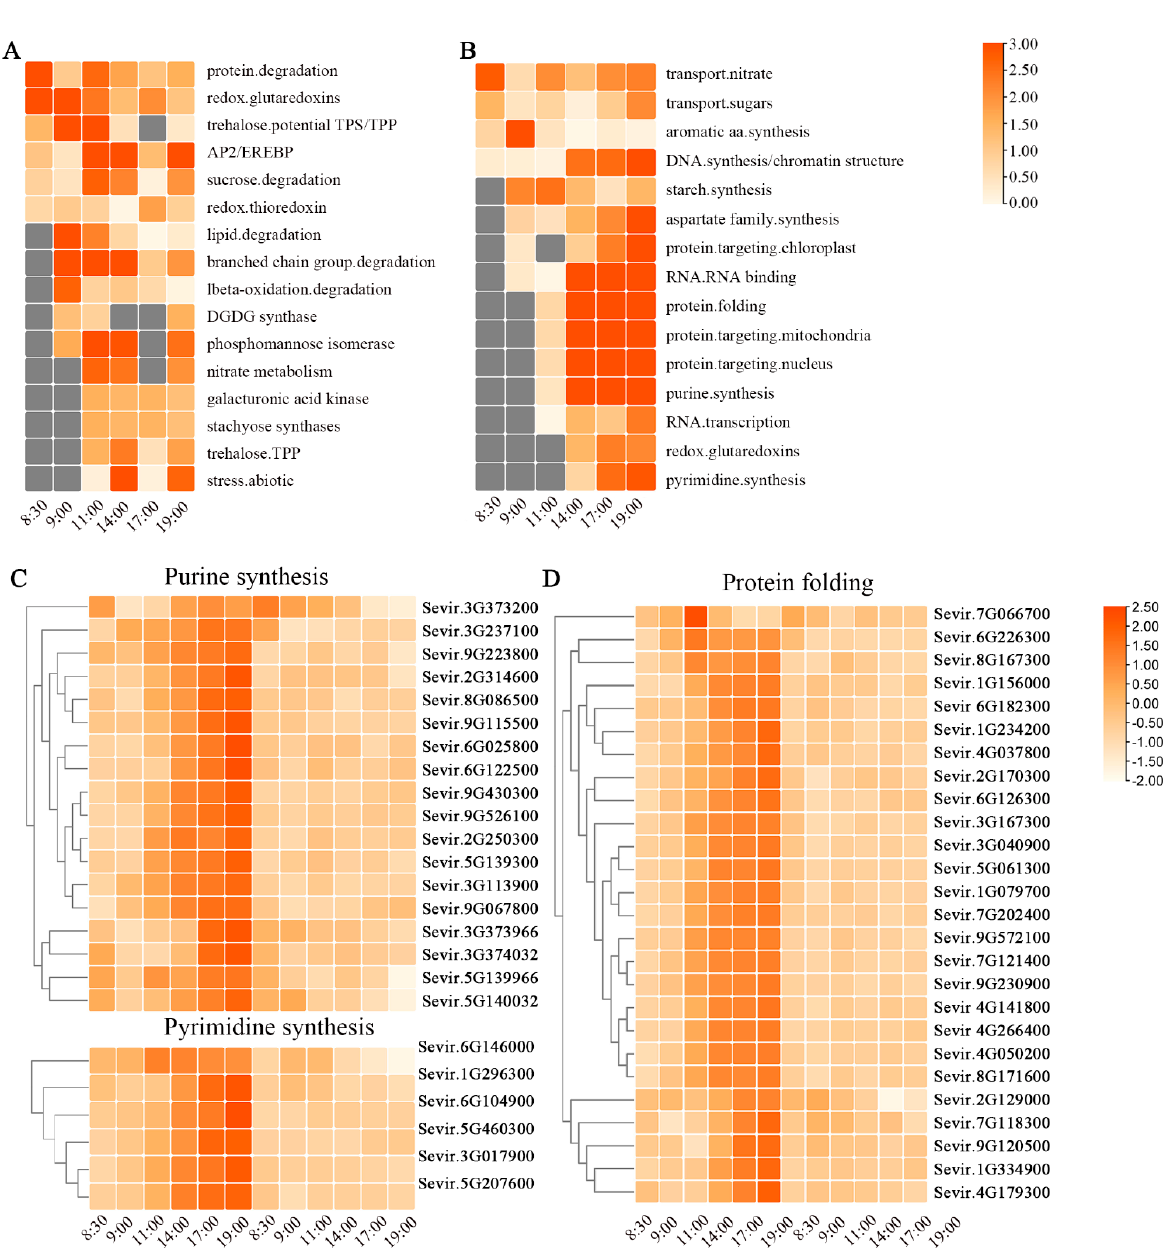
Figure 3. Functional category enrichment among DEGs after cold stress. ( A ) MAPMAN enrichment analysis of upregulated genes after cold stress. Only significant categories (FDR < 0.05) were dis- played. ( B ) MAPMAN enrichment analysis of downregulated gene after cold stress. Only significant categories (FDR < 0.05) were displayed. ( C , D ) The expression pattern of genes were involved in purine and pyrimidine synthesis ( C ) and proteins folding ( D ) at the six time points.